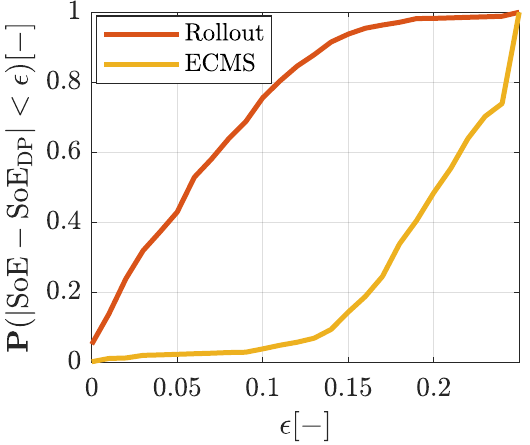
Figure 9. Probability distribution of the deviation between the optimal SoE (DP) and that obtained by the proposed online applicable method (rollout) and the standard online applicable method ECMS calibrated with a single